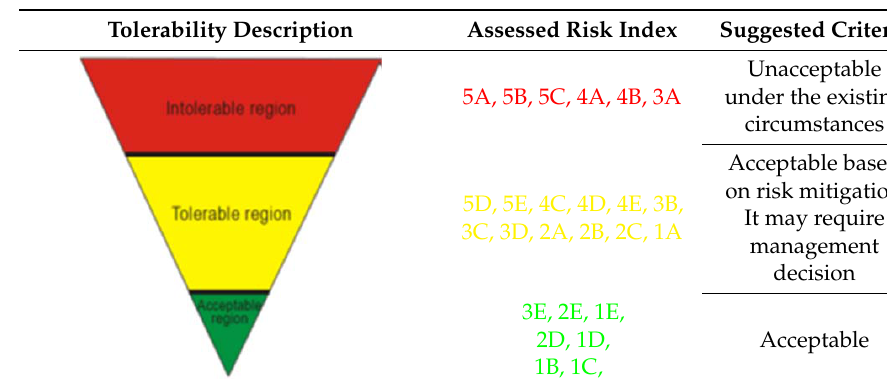
Table 5. Safety tolerability risk matrix [30].